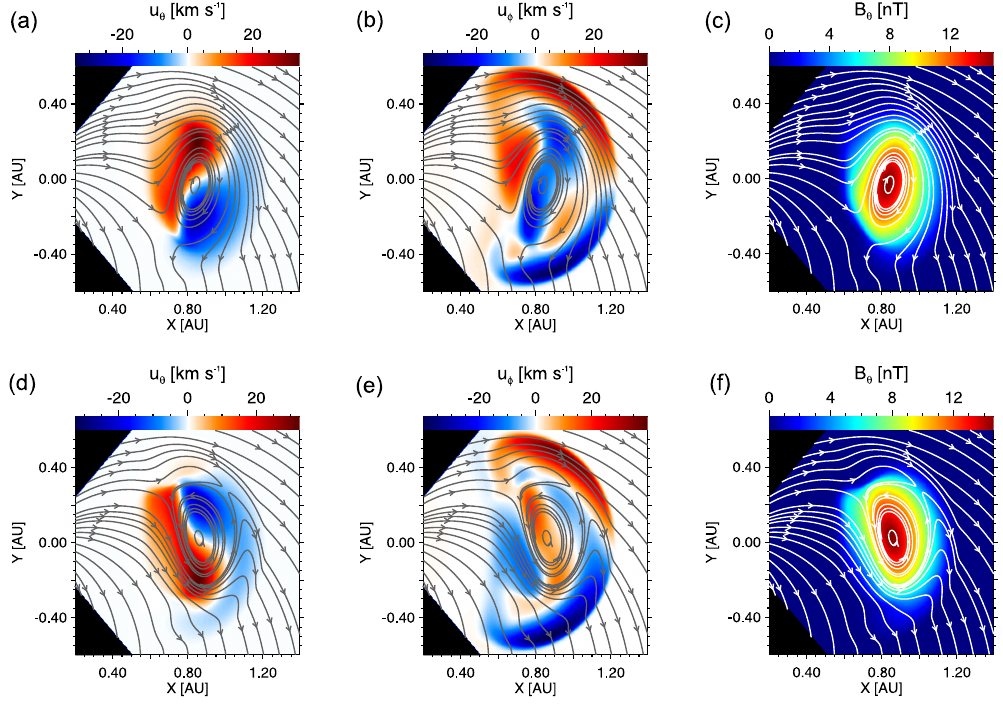
Fig. 7. Grids for the polar and azimuthal velocity components u θ and u φ of H − e (a, b) and of H + e (d, e) . The polar component B θ of the magnetic field is shown in (c) for H − e and in (f) for H + e . Projected magnetic field lines are over-plotted in gray/white